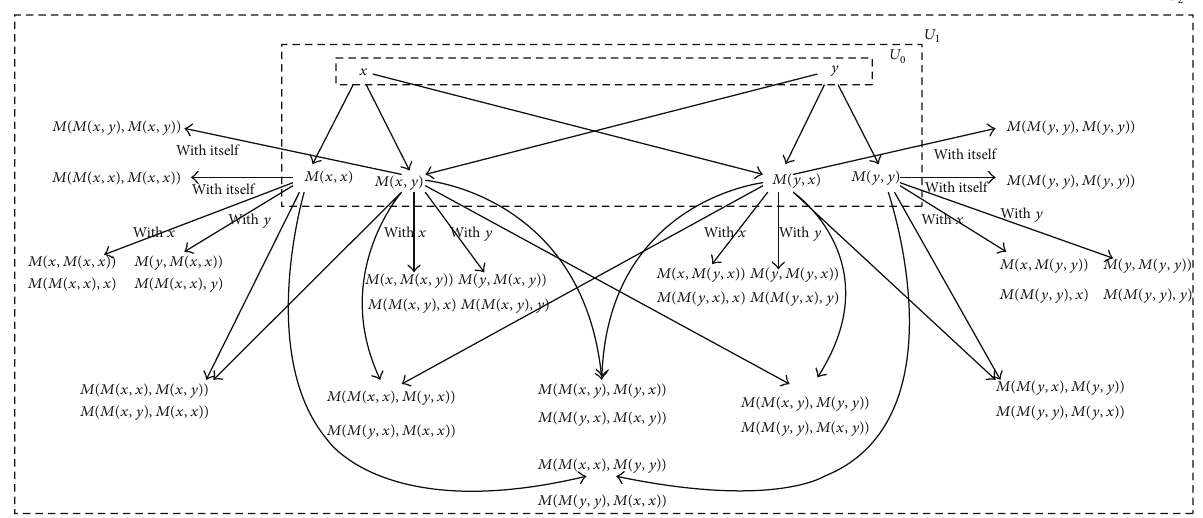
Figure 1: Iterates of a pair (𝑥,𝑦) under a bilinear operator 𝑀 in the sense of Grosse-Erdmann and Kim [24].